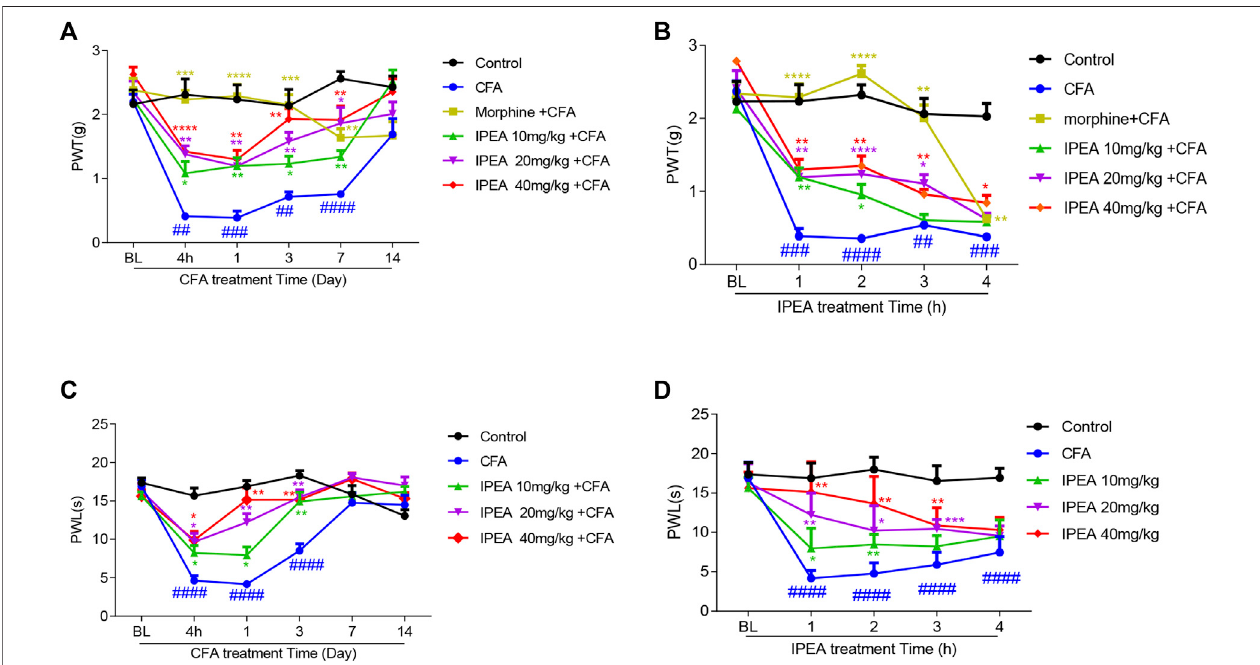
FIGURE 2 | Intraperitoneal injection of IPEA attenuates CFA-induced in fl ammatory pain of mice. (A,C) The time-course of IPEA on CFA-induced chronic in fl ammatory pain. Mice were daily administered with IPEA (i.p., 10 mg/kg, 20 mg/kg, and 40 mg/kg) after CFA injection. PWT or PWL of IPEA was measured 1 h after IPEA treatment on day 0 (prior to intraplantar injection), 4 h, day 1, day 3, day 7, day 14 after intraplantar injection of CFA. Two-way ANOVA revealed signi fi cant drug effects ( Figure 2A : F5, 30 (cid:2) 43.02, p < 0.0001; Figure 2C : F4,149 (cid:2) 30.43) and time effects ( Figure 2A : F4.266,128.0 (cid:2) 28.16, p < 0.0001; Figure 2C : F3.781, 112.7 (cid:2) 43.91, p < 0.0001) followed by Dunnett post hoc test (B and D) The time-course of IPEA on CFA-induced acute in fl ammatory pain. Morphine was 5 mg/kg. Two-way ANOVA revealed signi fi cant drug effects ( Figure 2B : F5, 30 (cid:2) 40.53, p < 0.0001; Figure 2D : F4, 25 (cid:2) 83.65, p < 0.0001) and time effect ( Figure 2B :